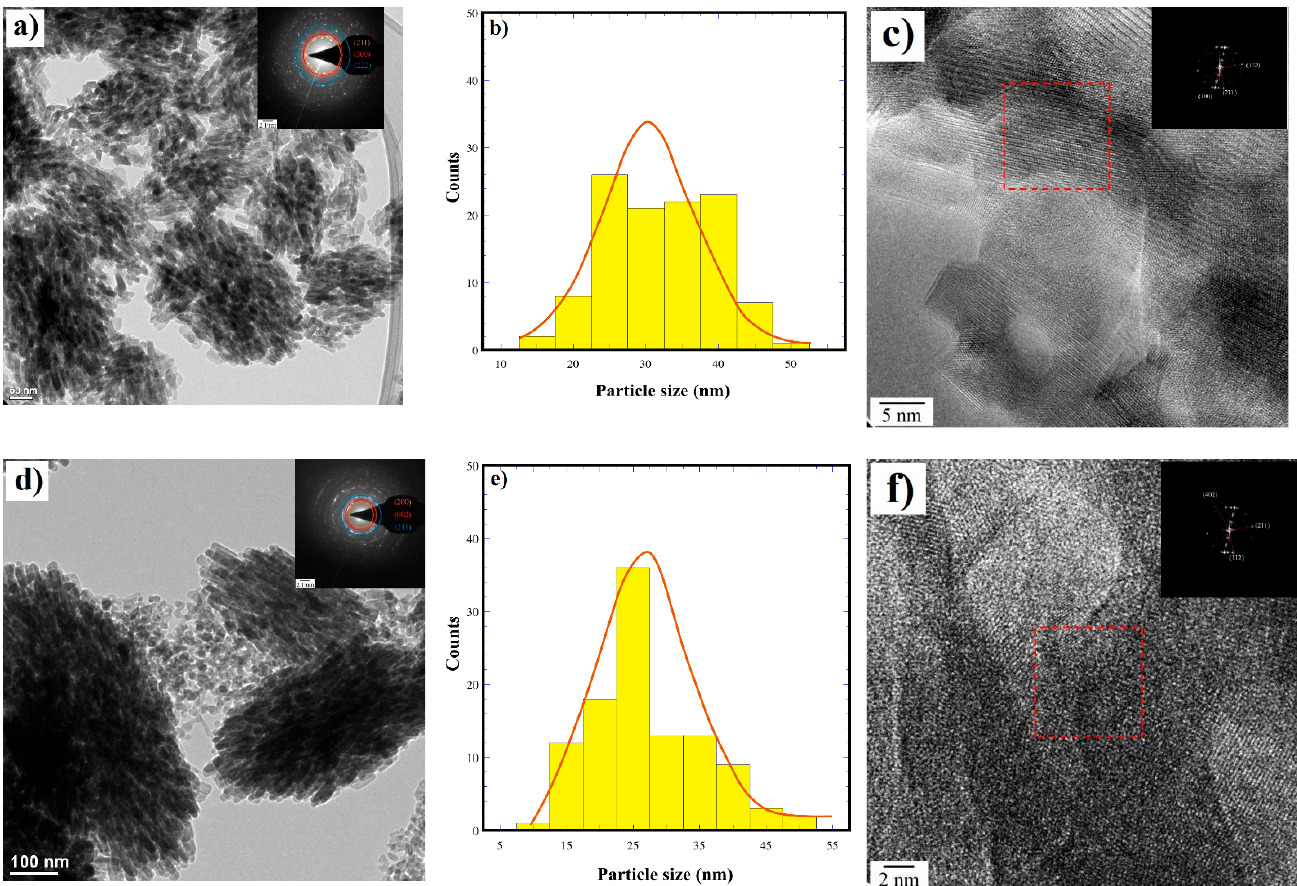
Figure 8. HRTEM micrographs of the Si-HAp powders prepared under an assisted hydrothermal process at 150 °C for 1 h using [(C 4 H 13 NO 5 Si 2 ) (TMAS)] 1.8 M: ( a – c ) 1.62 mol% of Si and ( d – f ) 12.15 mol% of Si.